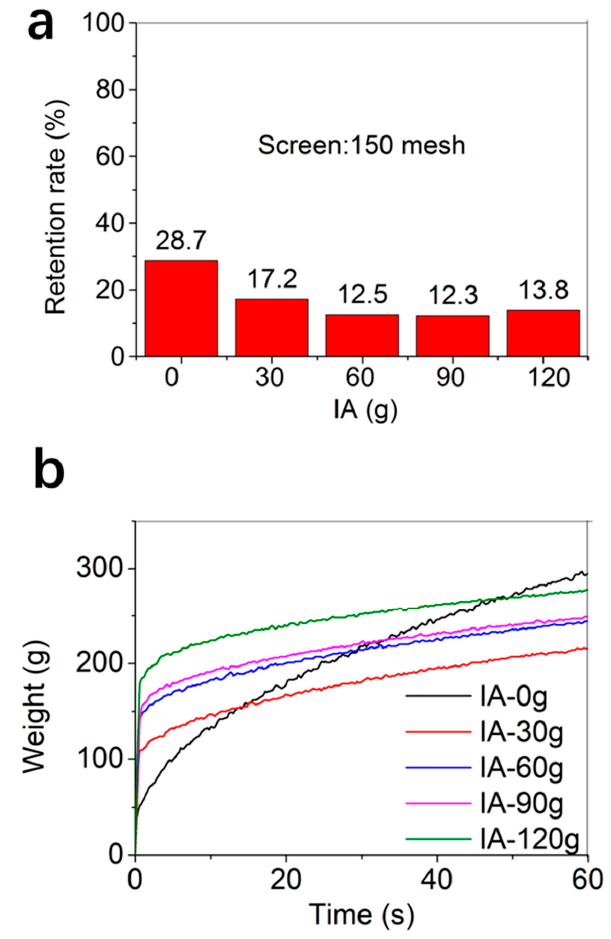
Figure 5. The retention percentages ( a ) and drainability curves (filtered water weight versus filtration time) ( b ) of the fire-resistant paper pulps based on ultralong HAP nanowires with different added amounts of IA.